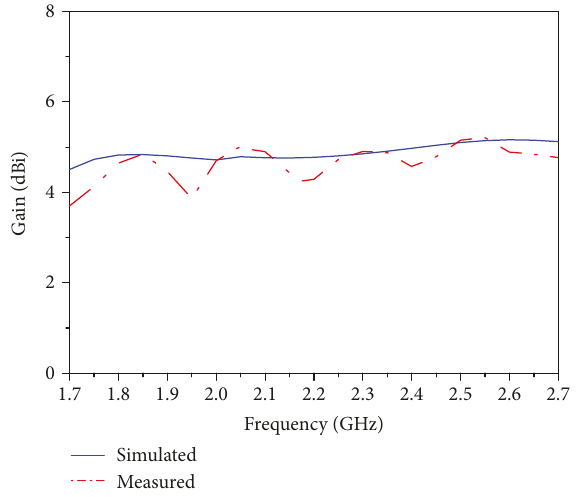
Figure 9: Gain of the wideband HP quasi-omnidirectional antenna.